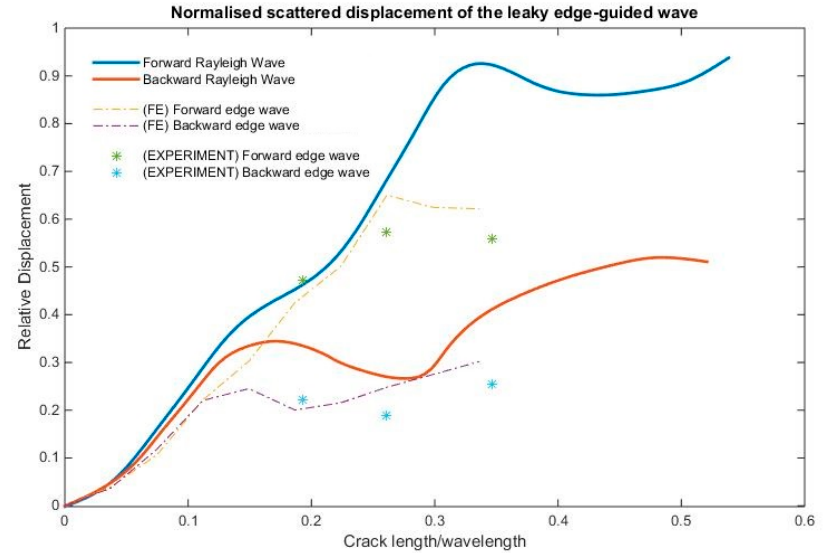
Figure 12. Experimental and computational comparison of the normalised scattered wave displacement of the edge-guided waves with respect to the incident wave maximum displacement, compared with the analytical Rayleigh wave case [13].